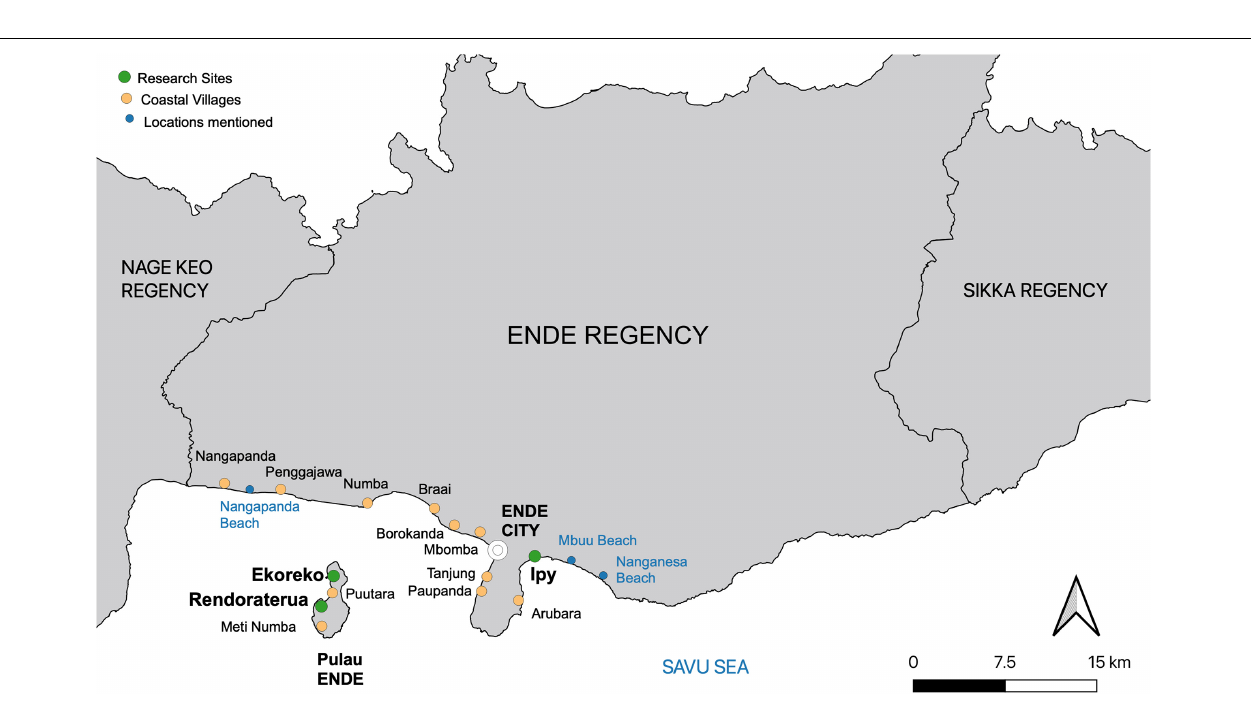
FIGURE 2 | Map of research sites along Ende Regency, Eastern